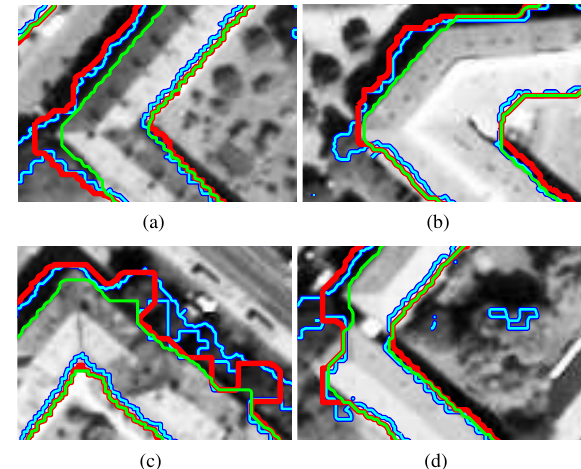
Figure 4: Comparing the boundary depictions of sample regions of the image I using the given mask M (blue), the filtered mask ˜ M (red), and the refined mask M R